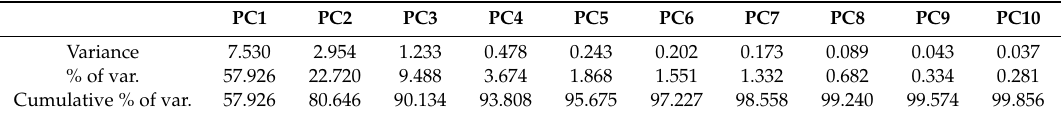
Table 7. Eigenvalues by shape factors.